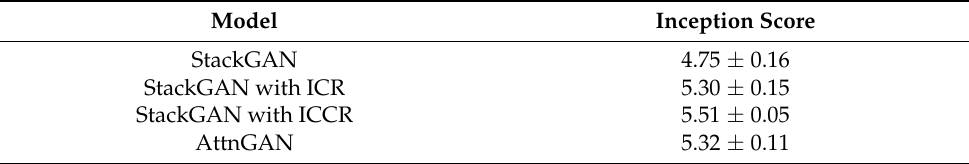
Figure 9. Example of mode collapse occurring in StackGAN. Table 1. Inception Score of each